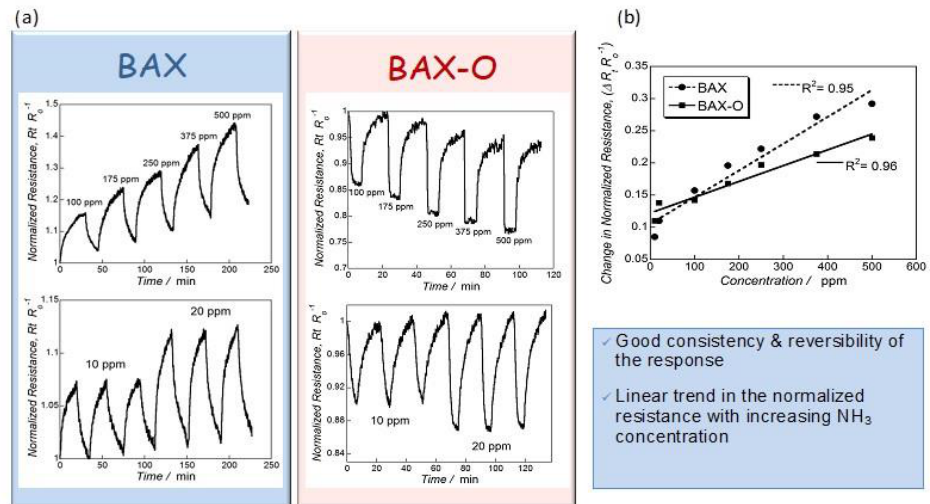
Figure 2. ( a ) Dependence of BAX and BAX-O responses (upper panel) on the NH 3 concentration and reproducibility of the resistance changes (lower panel) and ( b ) the linear response of the sensors on NH 3 concentration (upper panel). Adapted with permission from Reference [20]. Copyright 2015, The Royal Society of Chemistry.